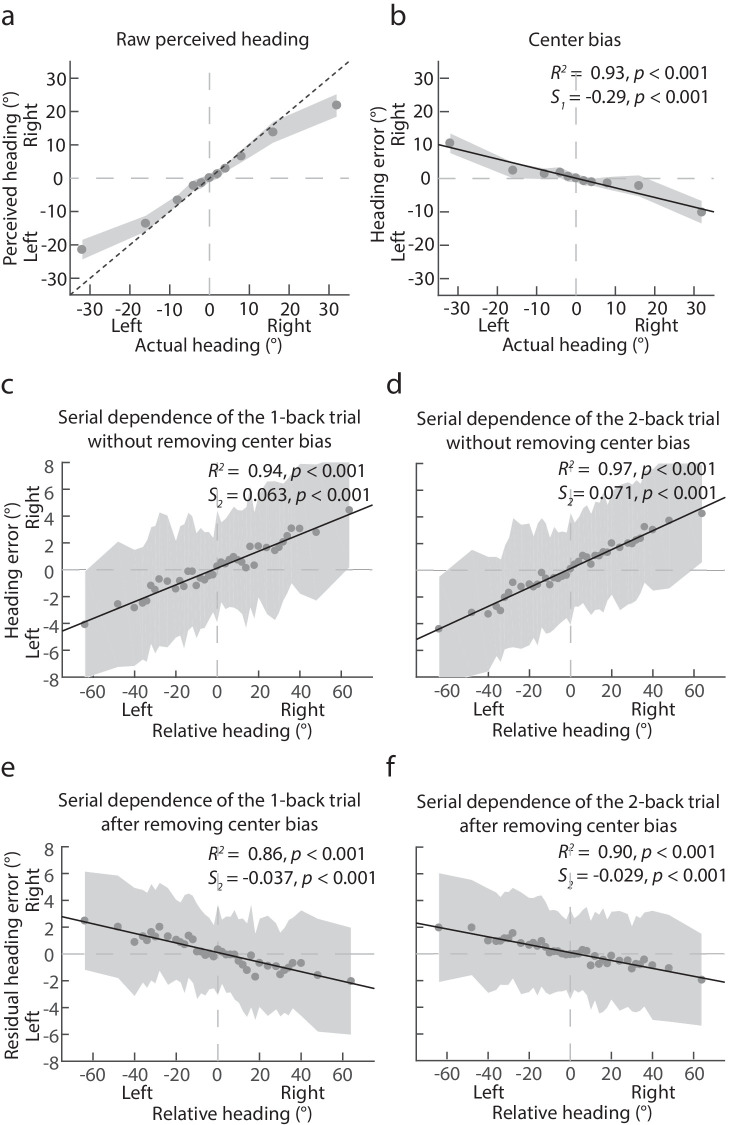

Experiment 1 data. (a) Mean perceived heading averaged across participants against actual heading. “Left” and “Right” on the x- and y-axis indicate the actual and the perceived heading to the left or right of the display center, respectively. The dotted line indicates the perfect response. (b) Mean observed heading error averaged across participants against actual heading. “Left” and “Right” on the x-axis indicates the actual heading to the left or right of the display center, and “Left” and “Right” on the y-axis indicates the observed heading error to the left or right of the actual heading. (c) Mean heading error against relative heading between the first previous trial (i.e. the 1-back trial) and the current trial or (d) between the second previous trial (i.e. the 2-back trial) and the current trial. (e) Mean residual heading error (i.e. the observed heading error minus the predicted heading error due to center bias) against relative heading between the first previous trial (i.e. the 1-back trial) and the current trial or (f) between the second previous trial (i.e. the 2-back trial) and the current trial. “Left” and “Right” on the x-axis indicate that the presented heading of the previous trial was to the left or right of the presented heading of the current trial. “Left” and “Right” on the y-axis indicate that the perceived heading was to the left or right of the predicted perceived heading. The shaded areas indicate ± 1 SD across 20 participants. The black solid lines show the best linear regression fits.